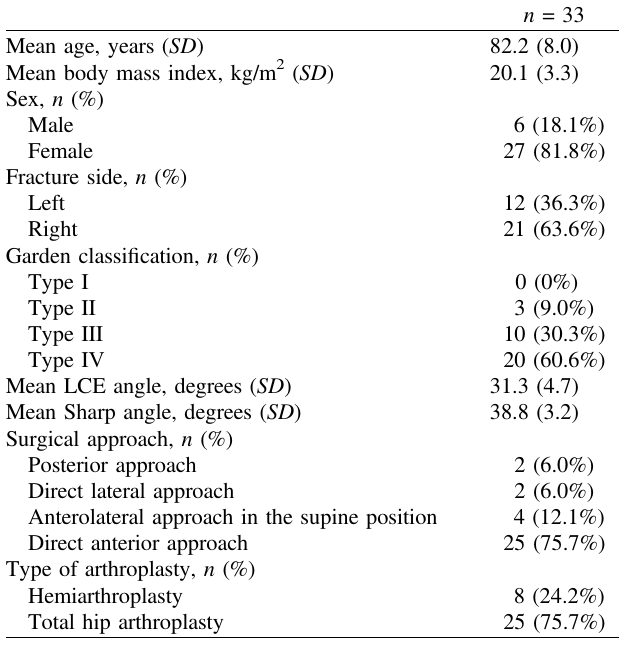
Table 1. Patient